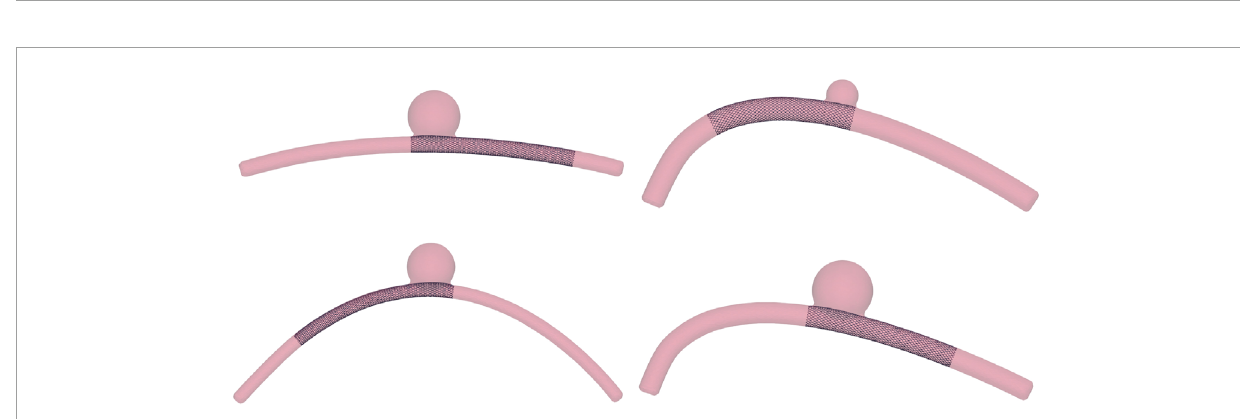
FIGURE 10 Four examples of false negatives misclassification from the test